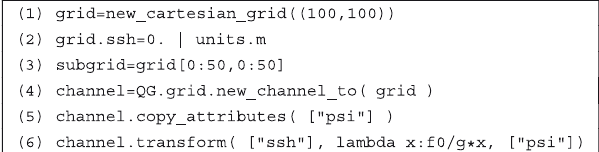
Figure 4. Example usage of the high-level grid data structure: (1) initialization of an empty Cartesian grid; (2) defining an at- tribute, here a scalar field of sea surface height; (3) subgrid genera- tion by indexing; (4) definition of an explicit channel from in-code storage to a grid in memory; (5) update of grid attributes over the channel; (6) functional transform over a channel.